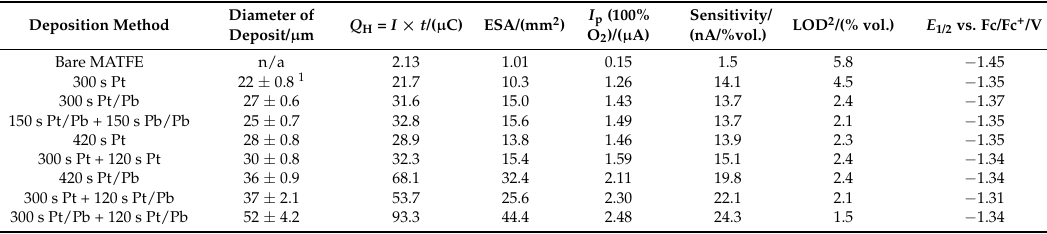
Table 2. Analytical parameters obtained: diameter of deposit, charge ( Q H ), electroactive surface area (ESA, calculated from the integration of H 2 desorption peak obtained in N 2 -saturated 0.5 M H 2 SO 4